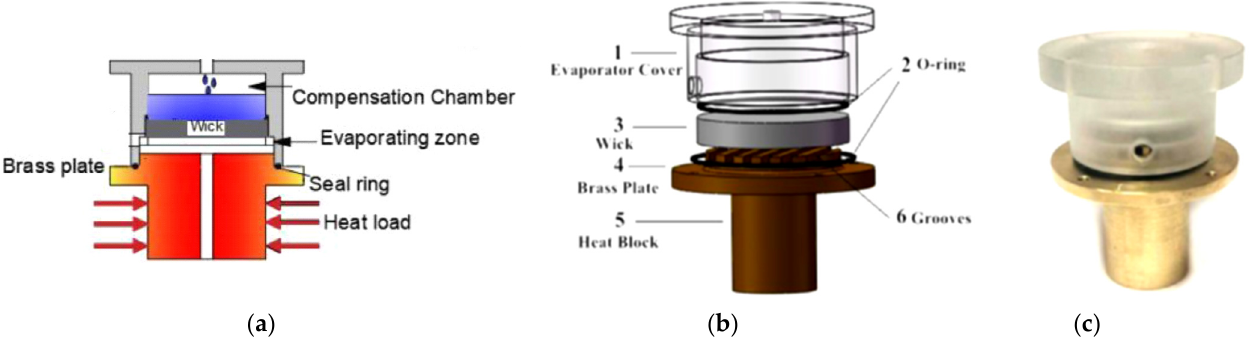
Figure 11. Schematic diagram ( a , b ) and photo of the evaporator ( c ) [39].